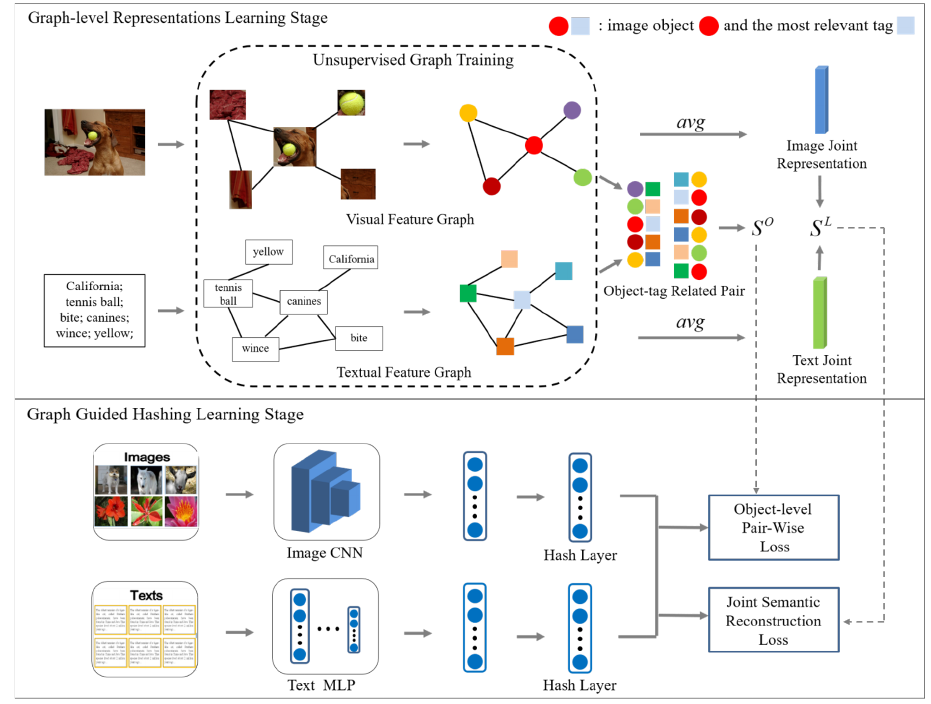
Figure 2. The overall framework of our proposed visual-textual correlation graph hashing (VCGH)